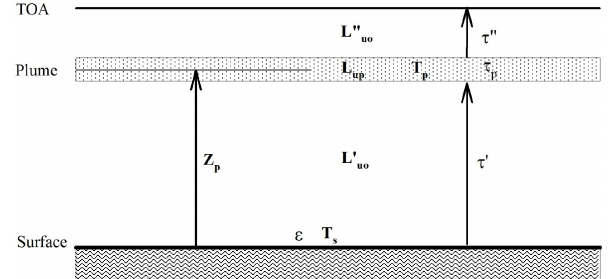
Figure 2. Scheme of the atmospheric model used in the improved VPR.